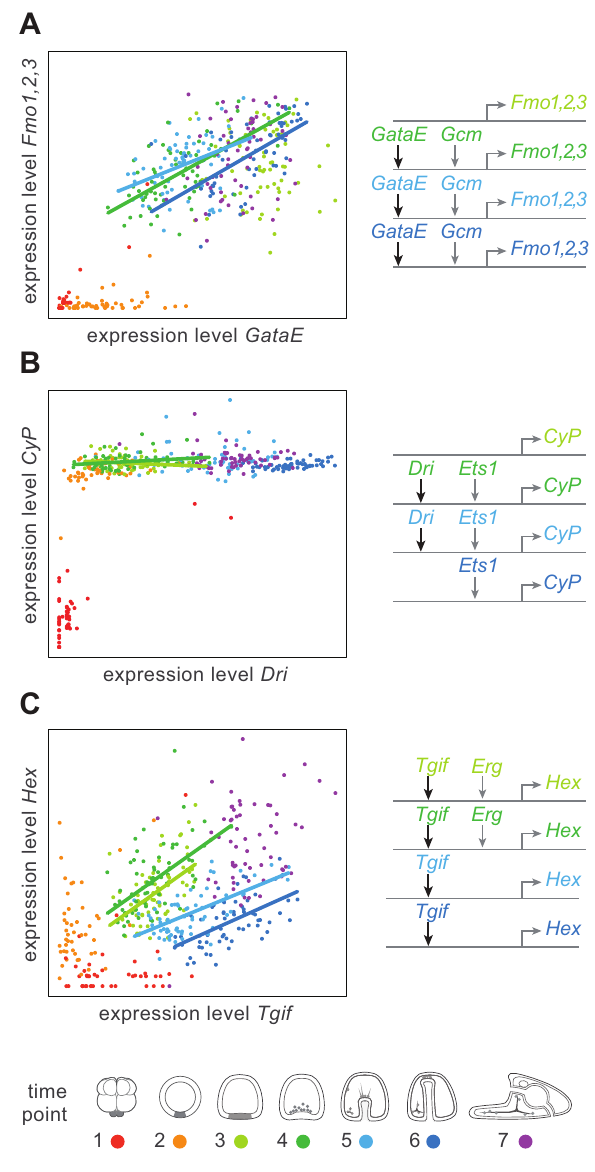
Figure 5. Correlations in gene expression levels among direct interactors. Scatter plots of expression levels for pairs of upstream regulators ( x -axis) and direct targets ( y -axis). Expression levels and regulatory interactions are color-coded by developmental time point (bottom). Regression lines are shown at active time points. Regulatory inputs to the downstream gene at active time points are drawn to the right of each plot using the same color-coding for time points. Information about active/inactive edges is not available for time point 7, which is therefore omitted. Note that gene regulatory interactions differ qualitatively. (A) Some are roughly linear: increased expression of the upstream gene (GataE) is correlated with increased expression of its direct target (Fmo1,2,3). (B) Other interactions are more switch-like: beyond a certain level, differences in expression of the upstream gene (Dri) has little impact on the expression level of its direct target (CyP). (C) Regulatory interactions can also change during development. Expression of Hex is sensitive to Tgif expression levels during all four active time points, but is more sensitive (steeper slope) when also receiving input from Erg (time points 3 and 4) than when it is not (time points 5 and 6).